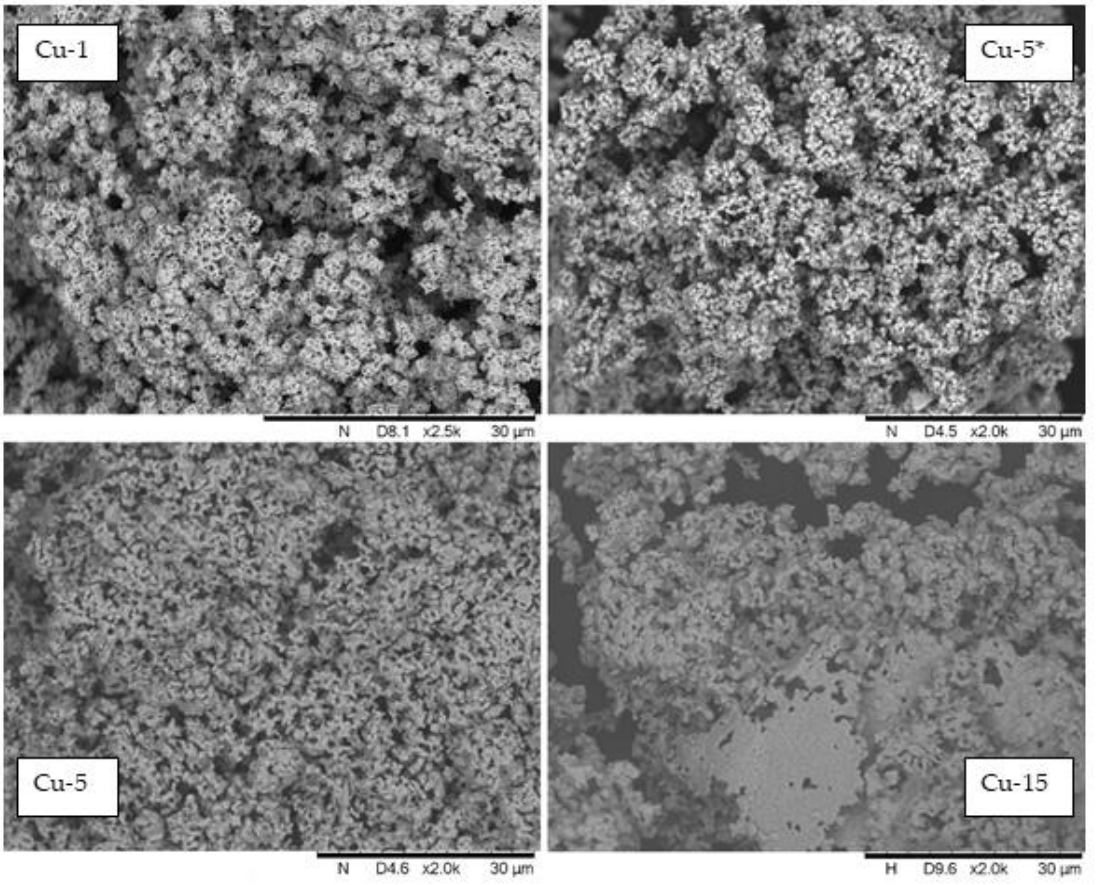
Figure 9. The SEM microphotographs of the copper catalysts (Cu-1, Cu-5*, Cu-5, Cu-15) generated in situ in the reaction medium during hydrogenolysis of glycerol.